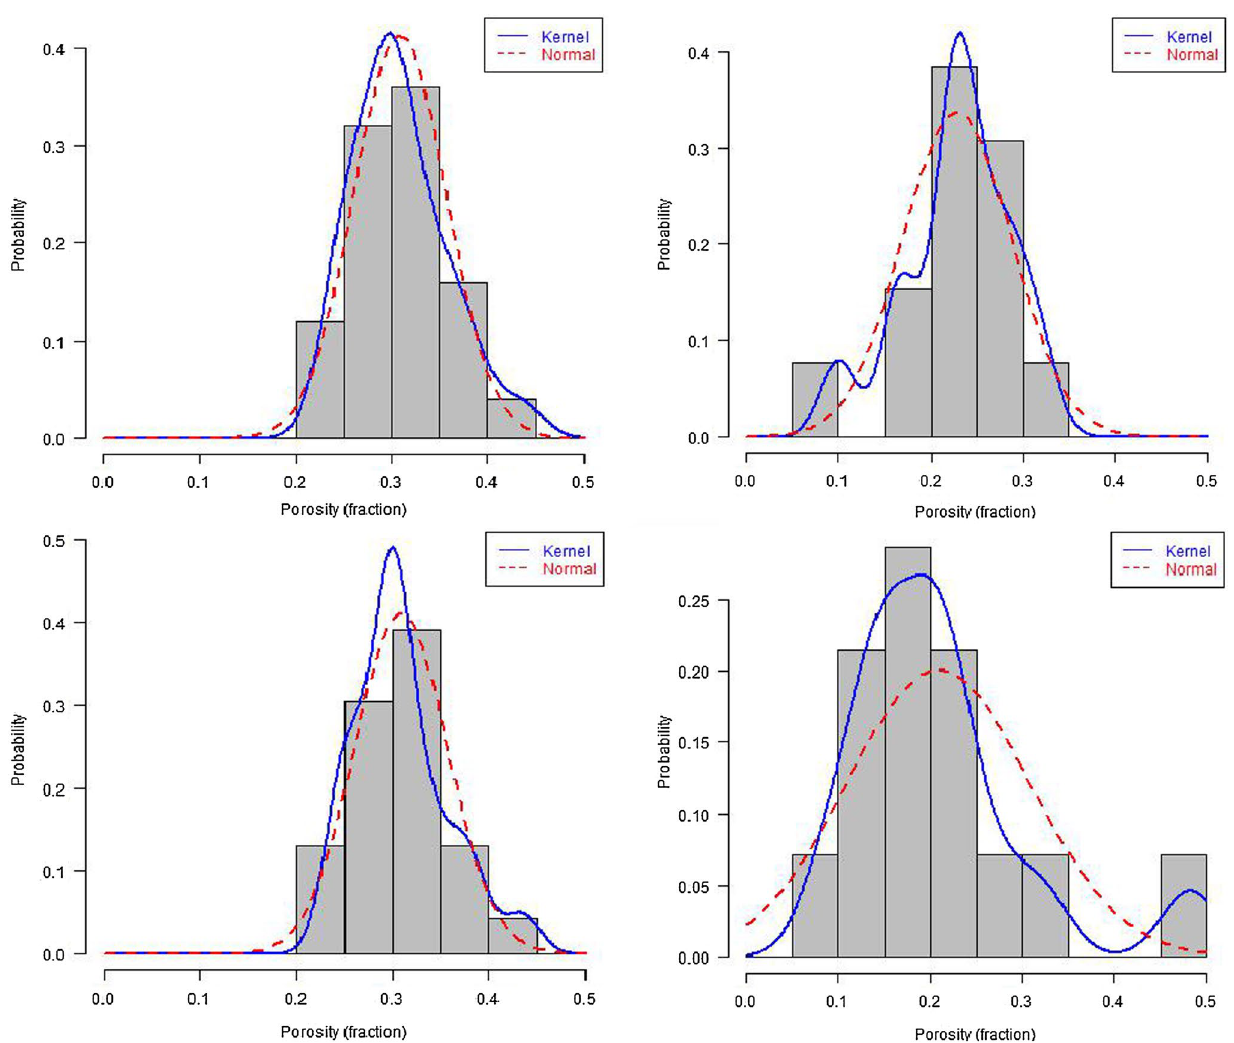
Fig. 17 Porosity values distributions for Well BH 19 (top left) and Well BH 29 (top right); Horizon X of Well BH 19 (bottom left) and Well BH 28 (bottom